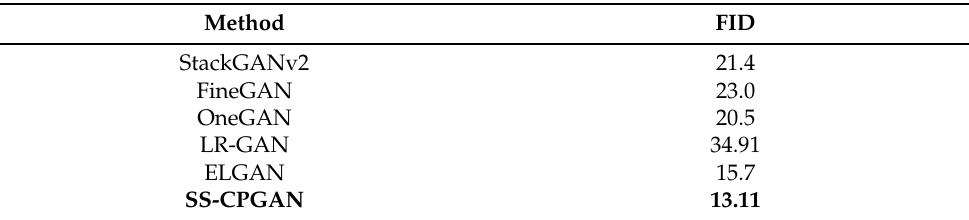
Table 4. FID comparison of our proposed method SS-CPGAN with the state-of-art on Caltech UCSD-Bird 200